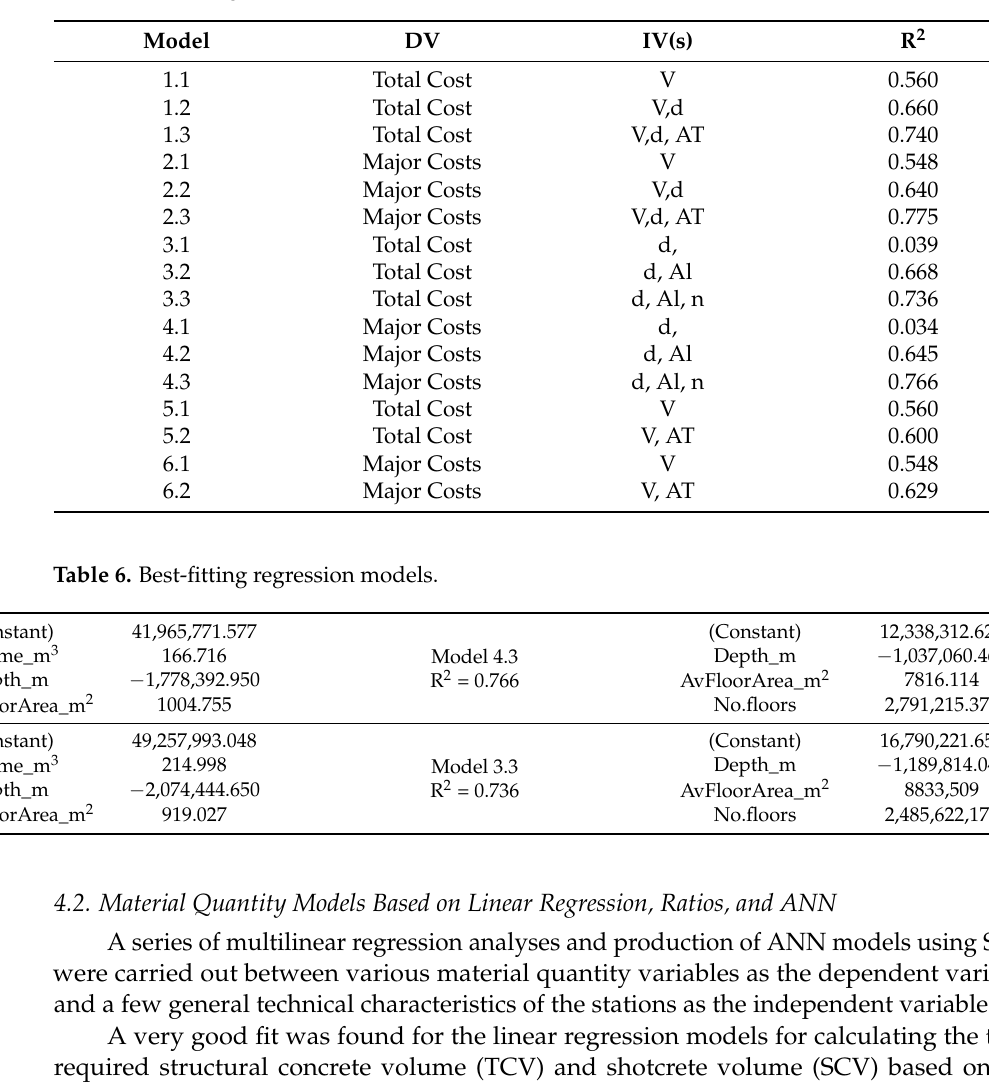
Table 5. Linear regression model results.